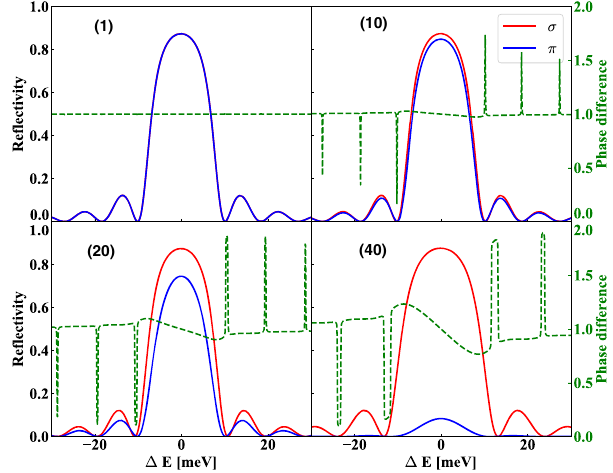
FIG. 10. The top plot shows the reflectivity in different polarized directions at different θ B . The bottom plot shows the ratio of reflectivity in the two polarizations with different crystal thickness. The ratio defines as the reflectivity in π polarization divides by that in σ